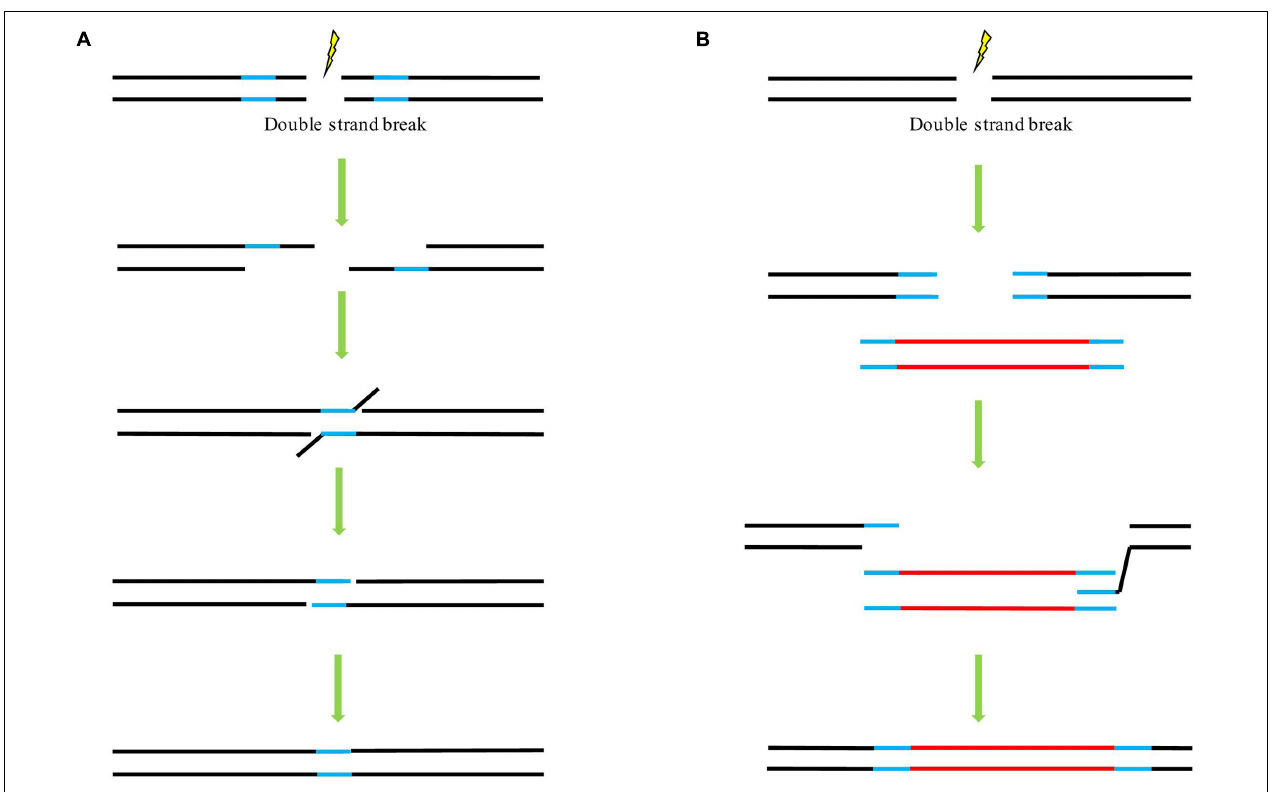
FIGURE 2 | The potential mechanisms underlying double strand break (DSB) repair upon the availability of a homologous template. (A) Single-strand annealing (SSA) pathway of homology-directed repair (HDR). (B) Synthesis-dependent strand annealing (SDSA) pathway of HDR. Lines in blue indicate the homologous sequences. Lines in red indicate the foreign